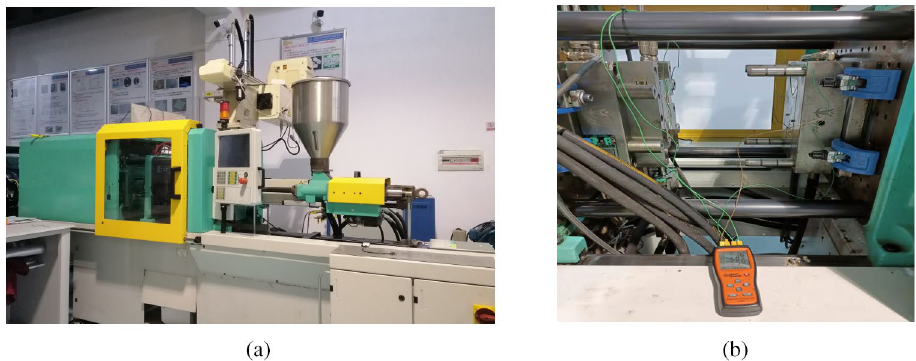
Figure 2. The injection molding system and the mold core of protein electrophoresis microfluidic chips ( a ) The injection molding system ( b ) The mold core.